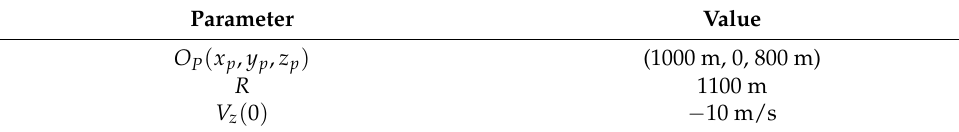
Table 1. Parameters of micro-downburst